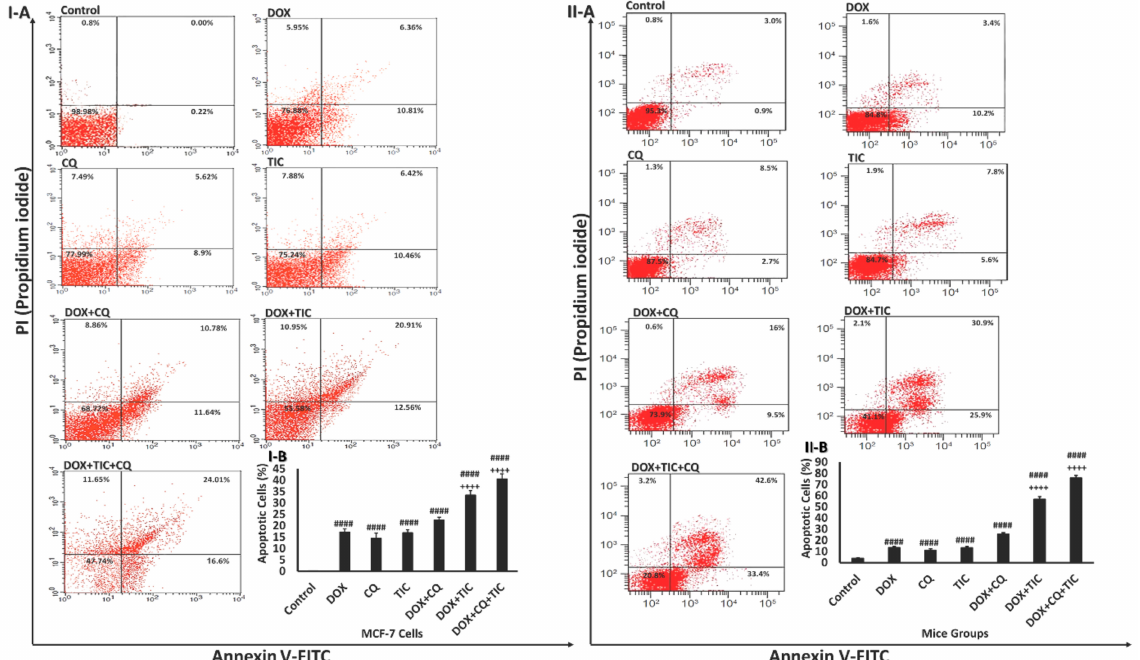
Figure 4. Effect of DOX, CQ and TIC single or combination treatments on the apoptotic cell population. Flow cytometric analysis showed AnnexinV-FITC/PI stained of MCF-7 cells ( I-A ) and MCF-7 Xenograft mice ( II-A ) treated with single or combinatorial treatments. In each panel, the lower and upper left quadrants represent the percent of viable and the dead cells, respectively. The lower and upper right quadrants represent the percent of early and late apoptotic cells, respectively. Bar diagram showing means % of apoptotic cell numbers of MCF-7 cells ( I-B ) and MCF-7 Xenograft mice ( II-B ) treated with single or combinatorial treatments. Values are expressed as mean ± SE ( n = 3). Means within columns carrying symbols are significantly different. # p < 0.05, ## p < 0.01, ### p < 0.001, #### p < 0.0001 compared with control (untreated group). + p < 0.05, ++ p < 0.01, +++ p < 0.001, ++++ p < 0.0001 compared with the DOX treated